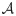
(Color online) Simulated magnetization harmonics are shown for values of A.The shapes of the curves are sigmoidal, showing that as the field amplitude is increased the magnetization saturation increases, and each harmonic saturates. The region of each harmonic containing the steepest slope provides the largest changes in the harmonic for small changes in the master variable time, i.e., the optimal sensitivity range for MSB biosensing.